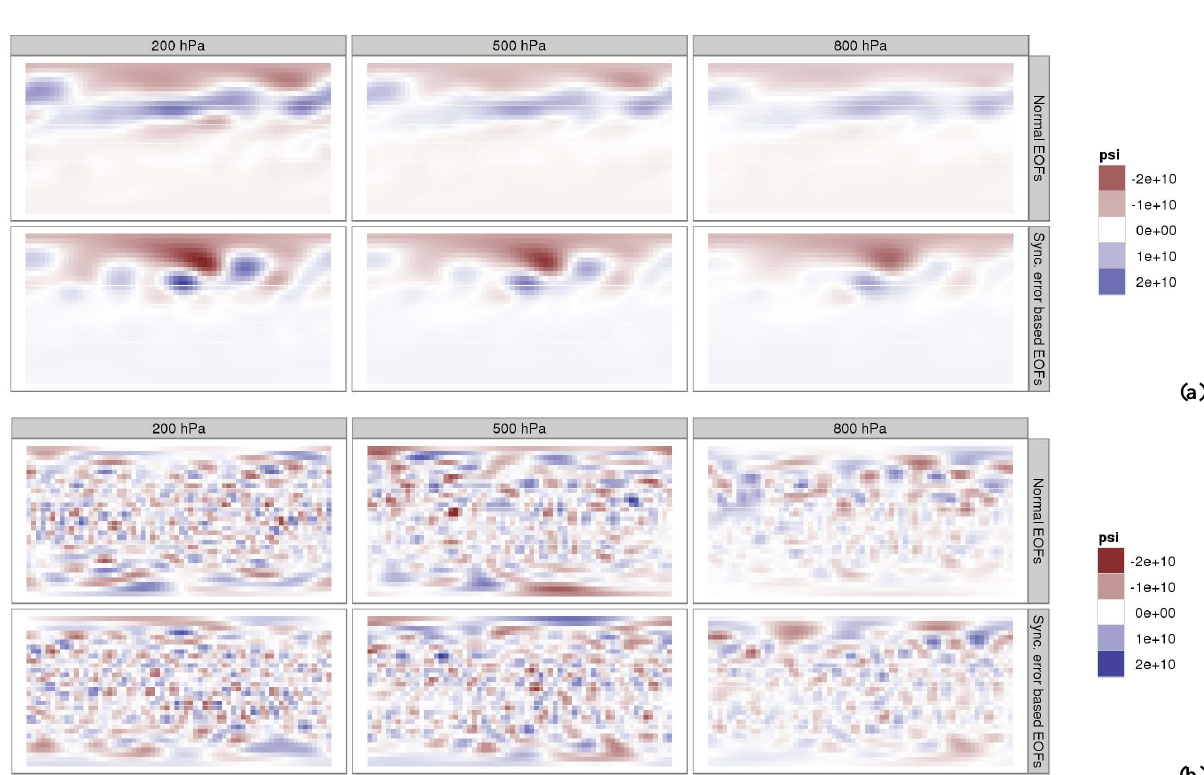
Fig. 5. Spatial EOF patterns for (a) the first EOF axis, and (b) for the 572nd EOF axis. The columns in the plots show the three levels in the QG model, the rows in the plot shows the two different types of EOFs: based on normal model output and based on the synchronization error of a loosely connected pair of QG